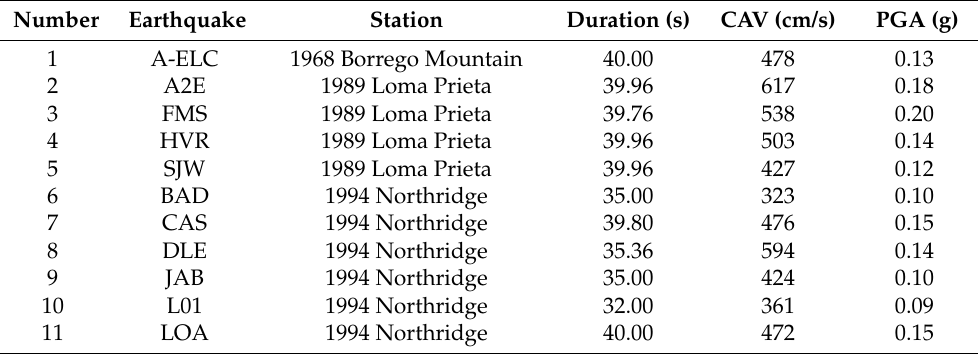
Table 3. Characteristics of the building. Table 4. Details of the earthquake records considered in this research